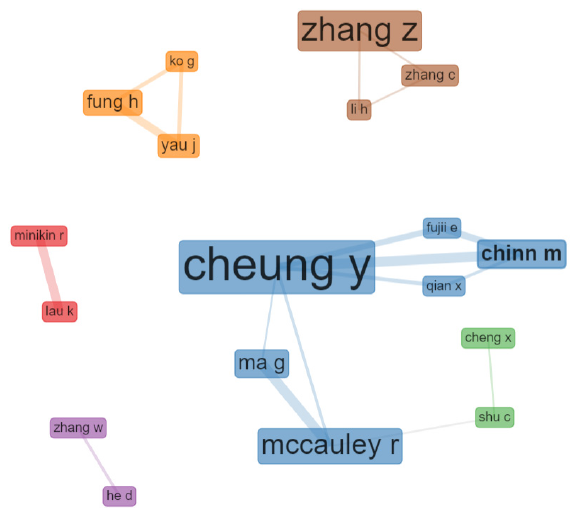
Figure 14. Authors’ collaboration network. Source: Authors’ elaboration using Biblioshiny.